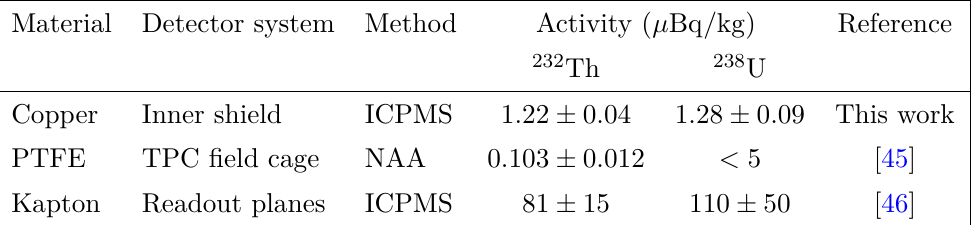
Table 1 . Specific activities of 232 Th and 238 U (parents of 208 Tl and 214 Bi , respectively) assumed in the background model of NEXT-1t for the most relevant materials used in the detector. Converting the activity of the parents of the natural decay chains, as measured by ICPMS and NAA, into activities of 208 Tl and 214 Bi requires the assumption of secular